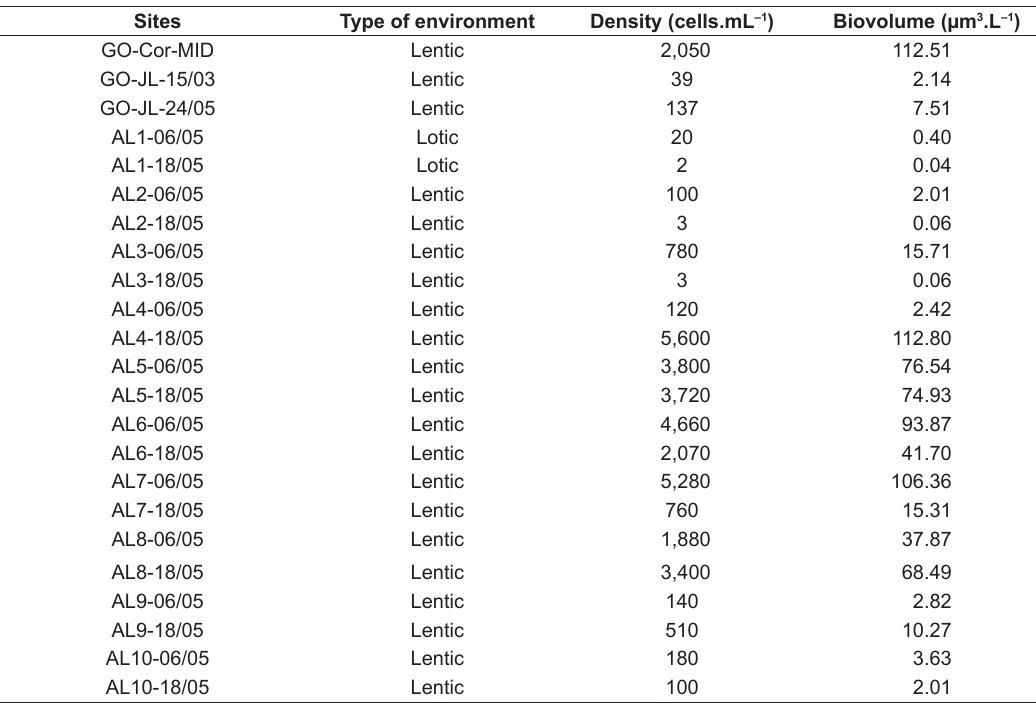
Table 2. Density and biovolume of Ceratium furcoides in Corumbá Reservoir and São Francisco River (for sites codes, see Table 1).